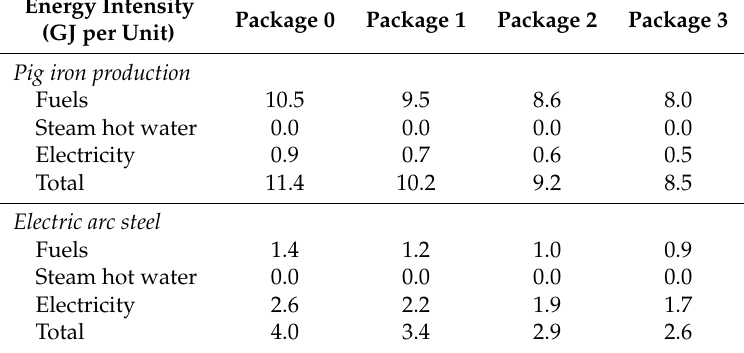
Table A2. Energy intensity per unit of output for two selected products in the Iron and Steel sector in China for different energy carriers.